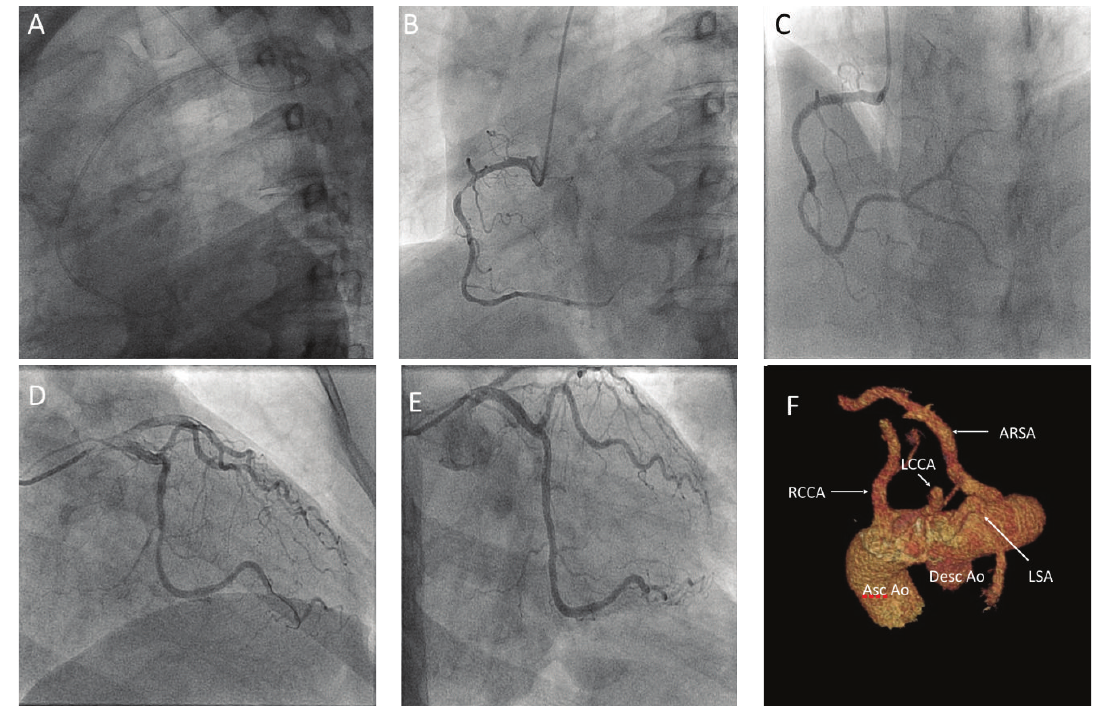
Figure 2: Angiographic images from Case 2: (A) lateral projection showing characteristic loop of ARSA; (B) left anterior oblique view of right coronary artery showing a 90% proximal lesion; (C) with subsequent stenting; (D) right anterior oblique caudal view of left coronaries with a 70% circumflex, 90% OM1, and 70% OM3; (E) final result; (F) A 3D volume rendered imaged from a contrast-enhanced CT angiographic dataset demonstrating vessels arising from the arch in the following order: RCCA, LCCA, LSA, and ARSA. ARSA, aberrant right subclavian artery;OM,obtusemarginal;RCCA,rightcommoncarotidartery;LCCA,leftcommoncarotid;LSA,leftsubclavianartery;AscAo,ascending aorta; Desc Ao, descending